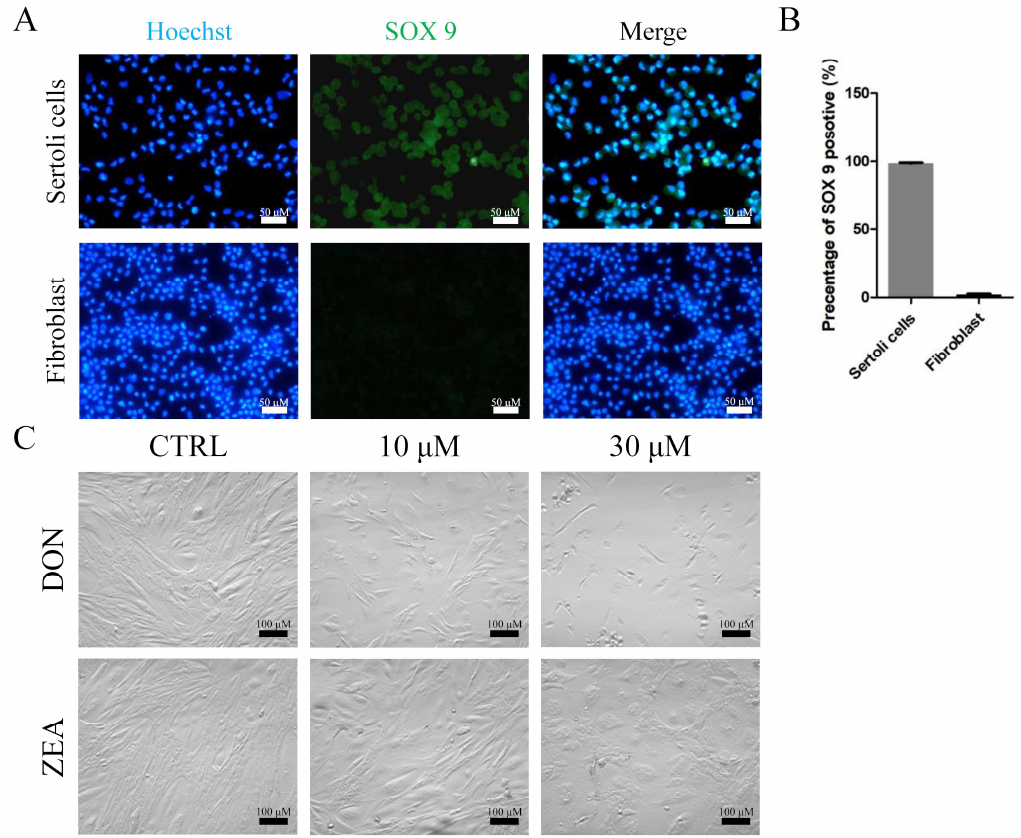
Figure 1. The purity of isolated SCs, as well as DON and ZEA exposure, affect the morphology of Equus asinus SCs. ( A ) The isolated cells were identified by SOX9 positivity using immunohistochemistry methods, and fibroblasts were used for contrast. Bar indicates 50 µ m. ( B ) The percentages of SOX9 -positive SCs. ( C ) The morphology of SCs following administration of 0 µ M, 10 µ M, and 30 µ M DON and ZEA after 72 h of culture in vitro. Bar indicates 100 μm.